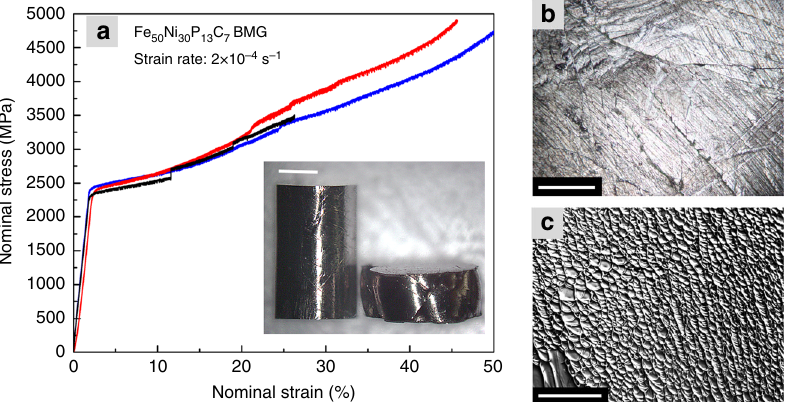
Fig. 1 Mechanical characterization of Fe 50 Ni 30 P 13 C 7 BMG. a Nominal stress vs. strain curves of the deformed BMG at a quasi-static strain rate of 2×10 − 4 /s. Inset shows the samples before and after deformation (up to 50% strain, scale bar 500 µ m). Small rises in the nominal stress (particularly in the black curve) are possibly due to sudden local fractures which temporarily change the deformation plane. b Deformation surface of the compressed BMG (sample belonging to the blue curve) showing multiple shear bands (scale bar 100 µ m). c The fracture surface corroborates the large plastic deformation of